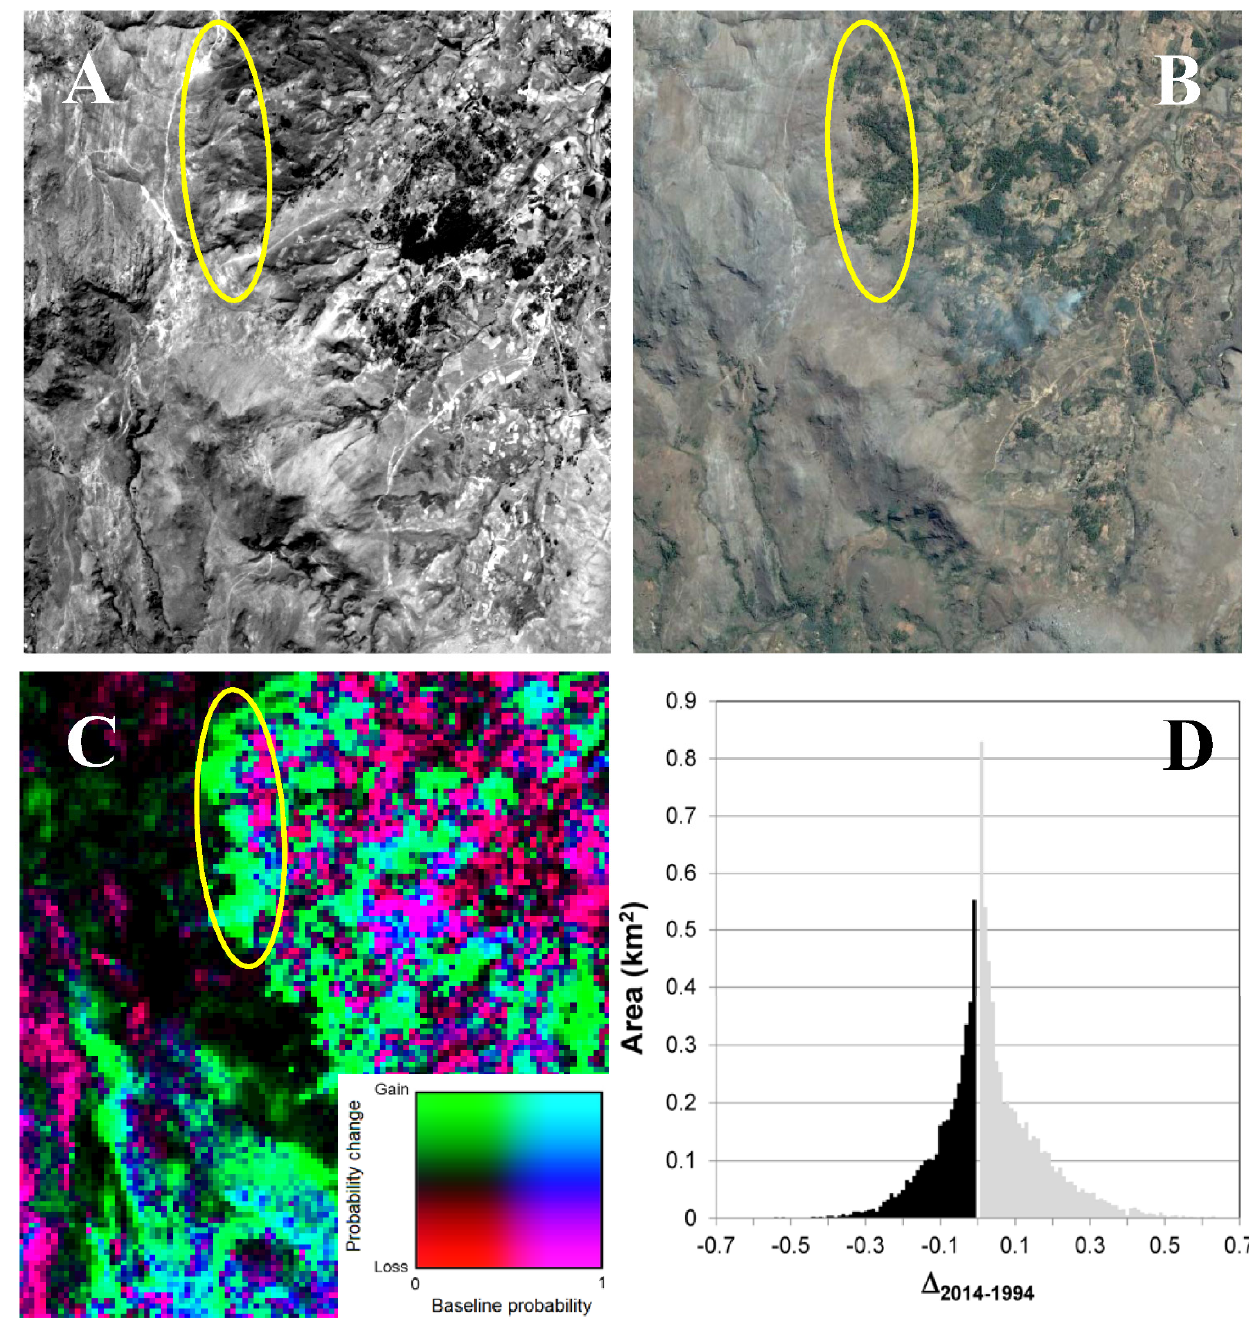
Figure 7. Dynamics of woody cover at Site 05, Soamahazina, an upland area southwest of Antsirabe (20°06'S, 46°54'E). ( A ) Aerial photograph taken in 1991. ( B ) CNES Astrium taken in 2013. ( C ) Change map based on Landsat imagery (see Figure 2). ( D ) Histogram depicting the frequency distribution of the delta of woody cover probability values between 2014 and 1994 based on Landsat imagery. Woody cover loss is represented in black, while gain is represented in gray. Ellipses in (A–C) relate to a particular woody cover dynamic described in the text. See Figure 1 for the geographic location of Site 05 within the study